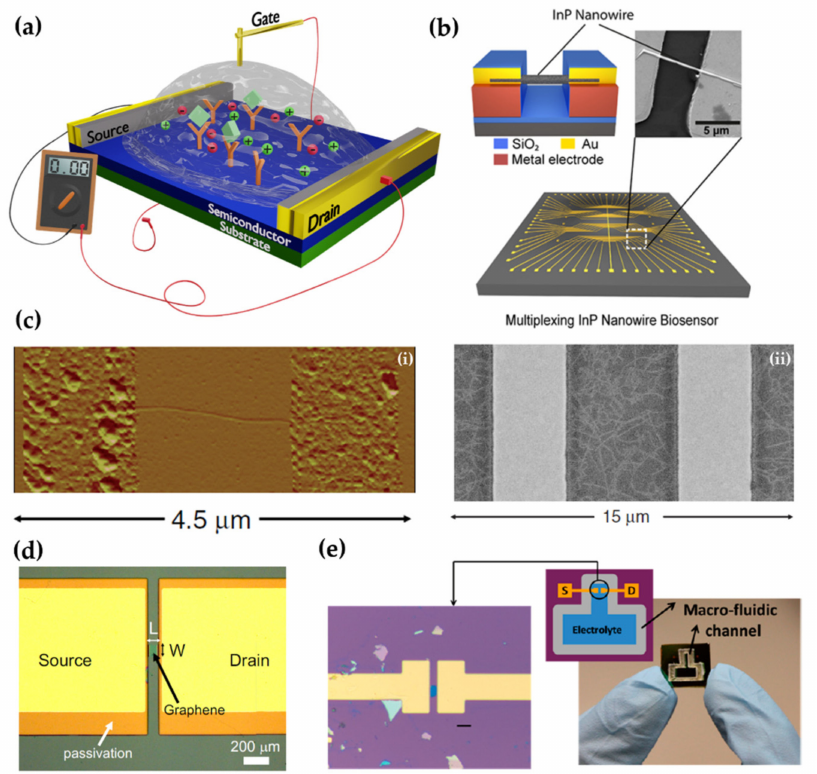
Figure 2. ( a ) Sketch of a solution-gated field-effect transistor (SGFET) immunosensor platform. A source, a drain, and gate electrodes form the basics of a FET device. The biorecognition event occurs when the antigens (light green squares) bind to its specific antibody (orange Y), immobilized at the surface of the semiconductor. Examples of immunosensors based field-effect transistor (FET). ( b ) Indium phosphide (InP) nanowire (NW) FET device and scanning electron microscopy (SEM) image showing the InP NW between source and drain electrode. Adapted from [55] with permission from ACS. ( c ) Carbon nanotubes (CNTs) FET device ( i ) atomic force microscopy (AFM) image showing an individual single-walled carbon nanotube (SWCNT) between source and drain electrodes and ( ii ) an SEM image of an array of SWCNTs. Adapted from [56] with permission from Wiley. Optical image of ( d ) graphene and ( e ) molybdenum disulfide (MoS 2 ) FET devices. Adapted from [57] and [58], respectively, with permission from